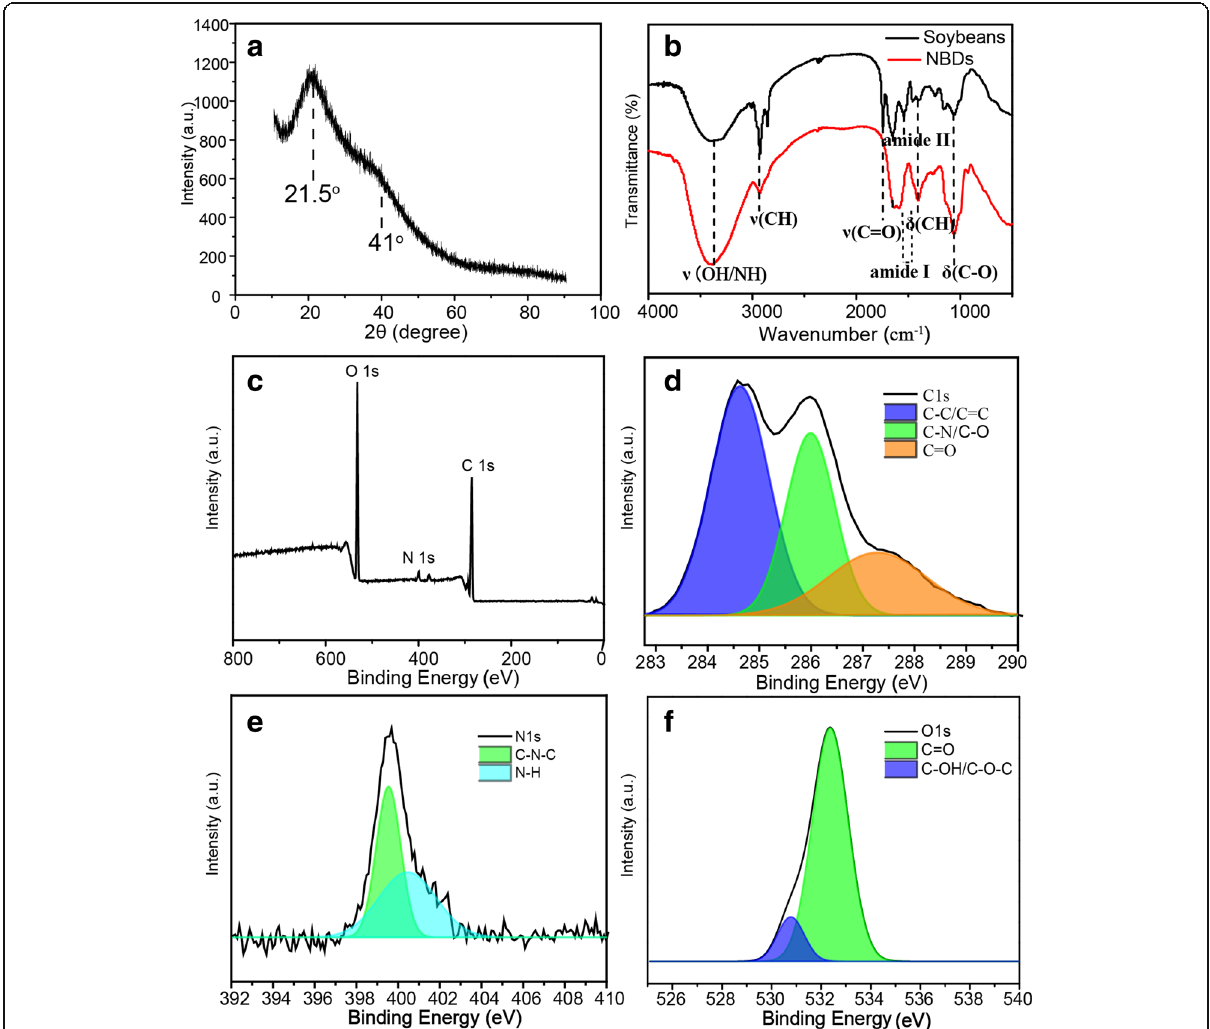
Fig. 2 a XRD pattern of the NBDs. b FTIR spectra of the soybean and NBDs. c XPS survey spectrum of the NBDs. High-resolution XPS spectra of C 1s ( d ), N 1s ( e ), and O 1s ( f